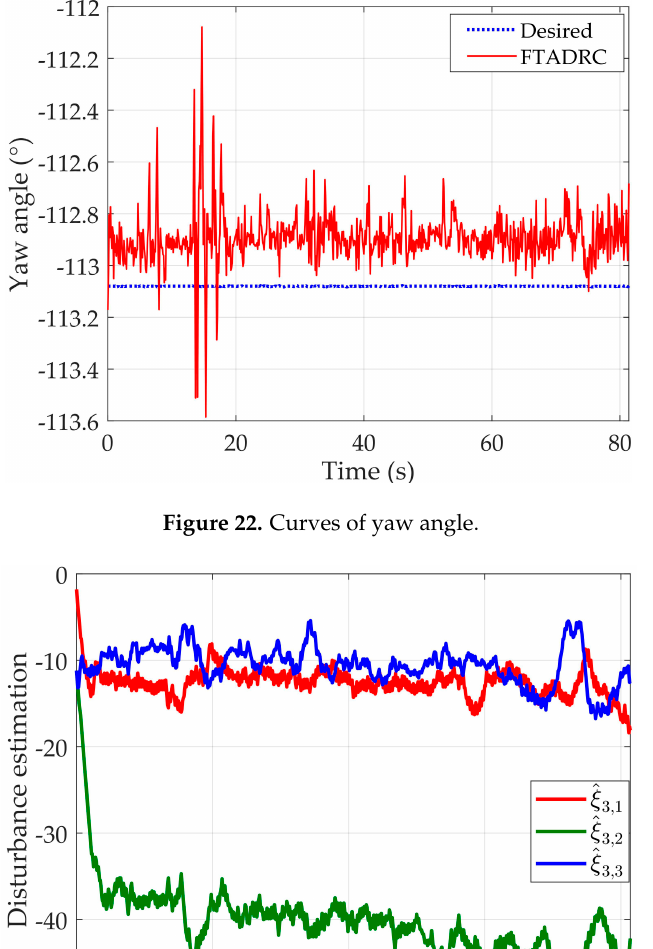
Figure 21 . Curves of pitch angle.